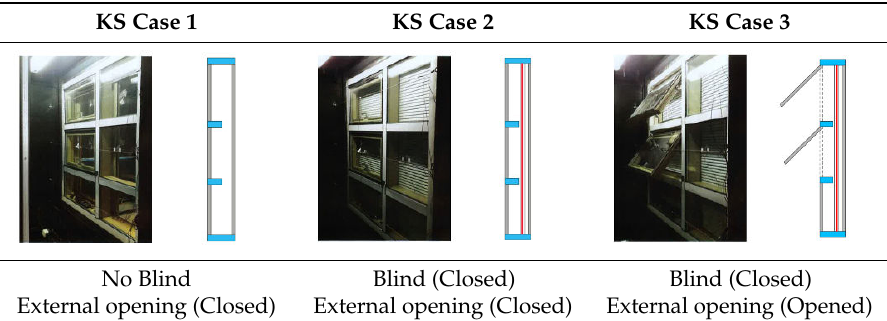
Table 4. Setting conditions for blind and external opening.